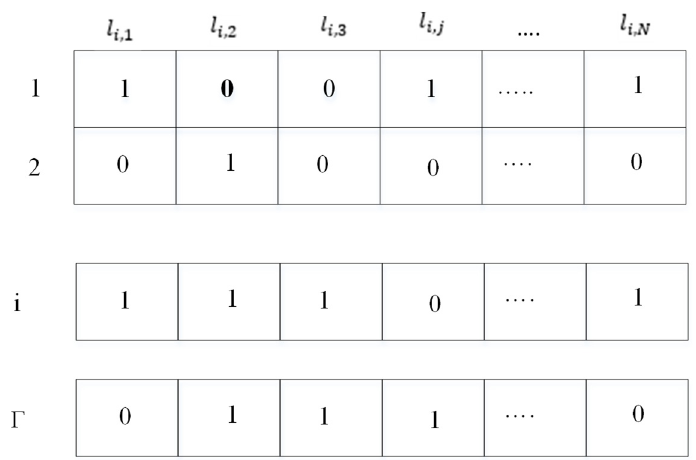
Figure 3. Binary definition of individuals in the improved dragonfly optimization algorithm for energy-aware coverage optimization.